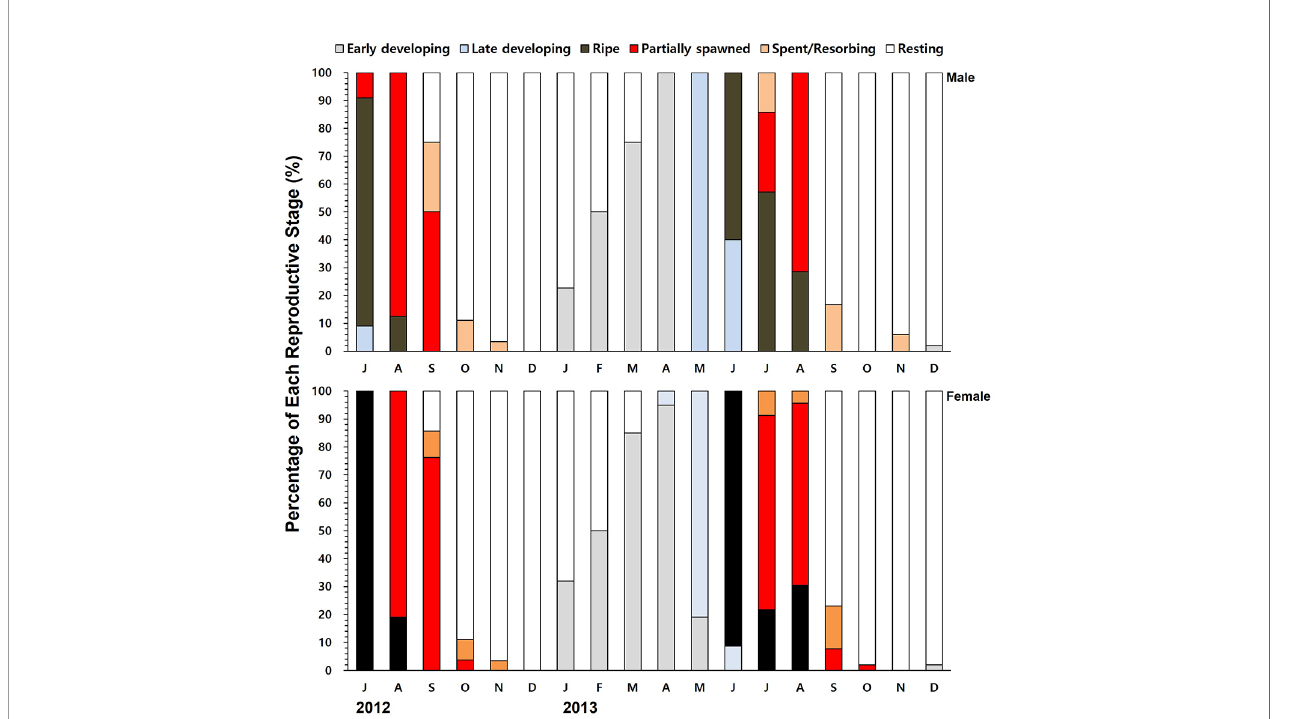
FIGURE 5 | The monthly percentage composition of different gametogenic stages of the males and